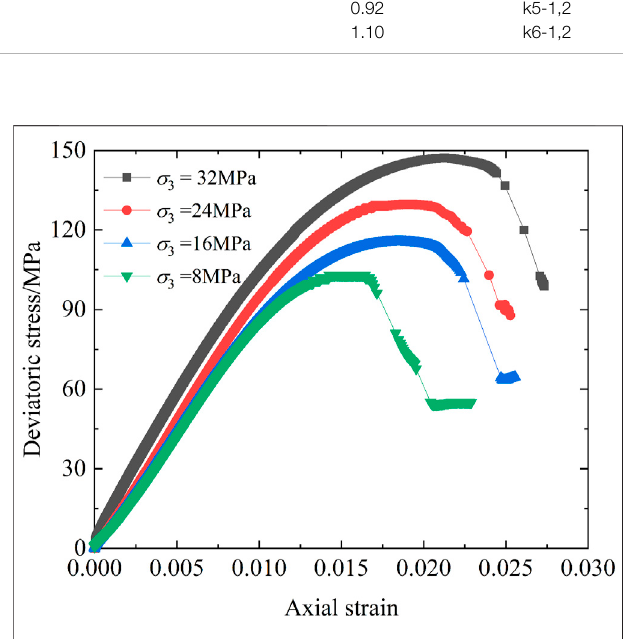
FIGURE 4 | Deviatoric stress axial strain curves under different con fi ning pressures. Stress – strain relationship under constant con fi ning stiffness tests.